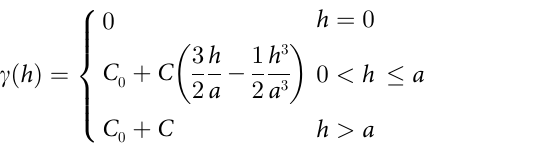
> 1.5 MJ hm -2 h -1 and b) at threshold z > k k